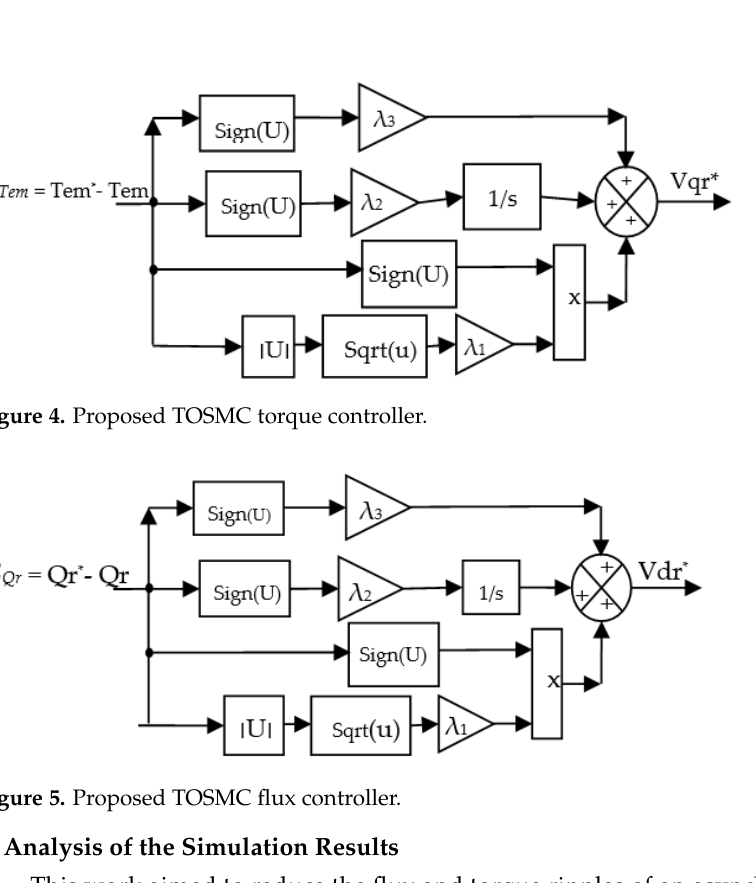
Figure 7. THD value of the stator current (DFTC-TOSMC).